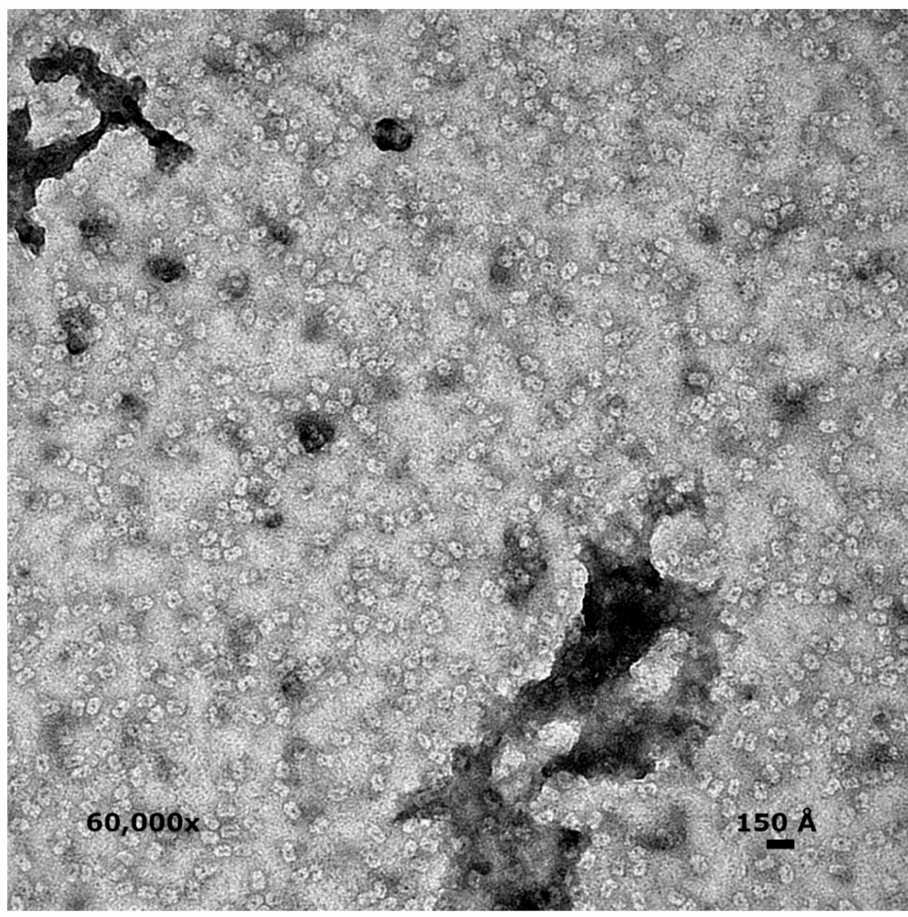
Figure 5. Uranyl acetate staining of gp11 showed cylindrical particles with heavily stained central regions. Magnification is 60,000 × . These images more closely resemble the prolate envelope predicted by SAXS. A hollow cylinder with a central channel >~20 Å would allow DNA to pass through the